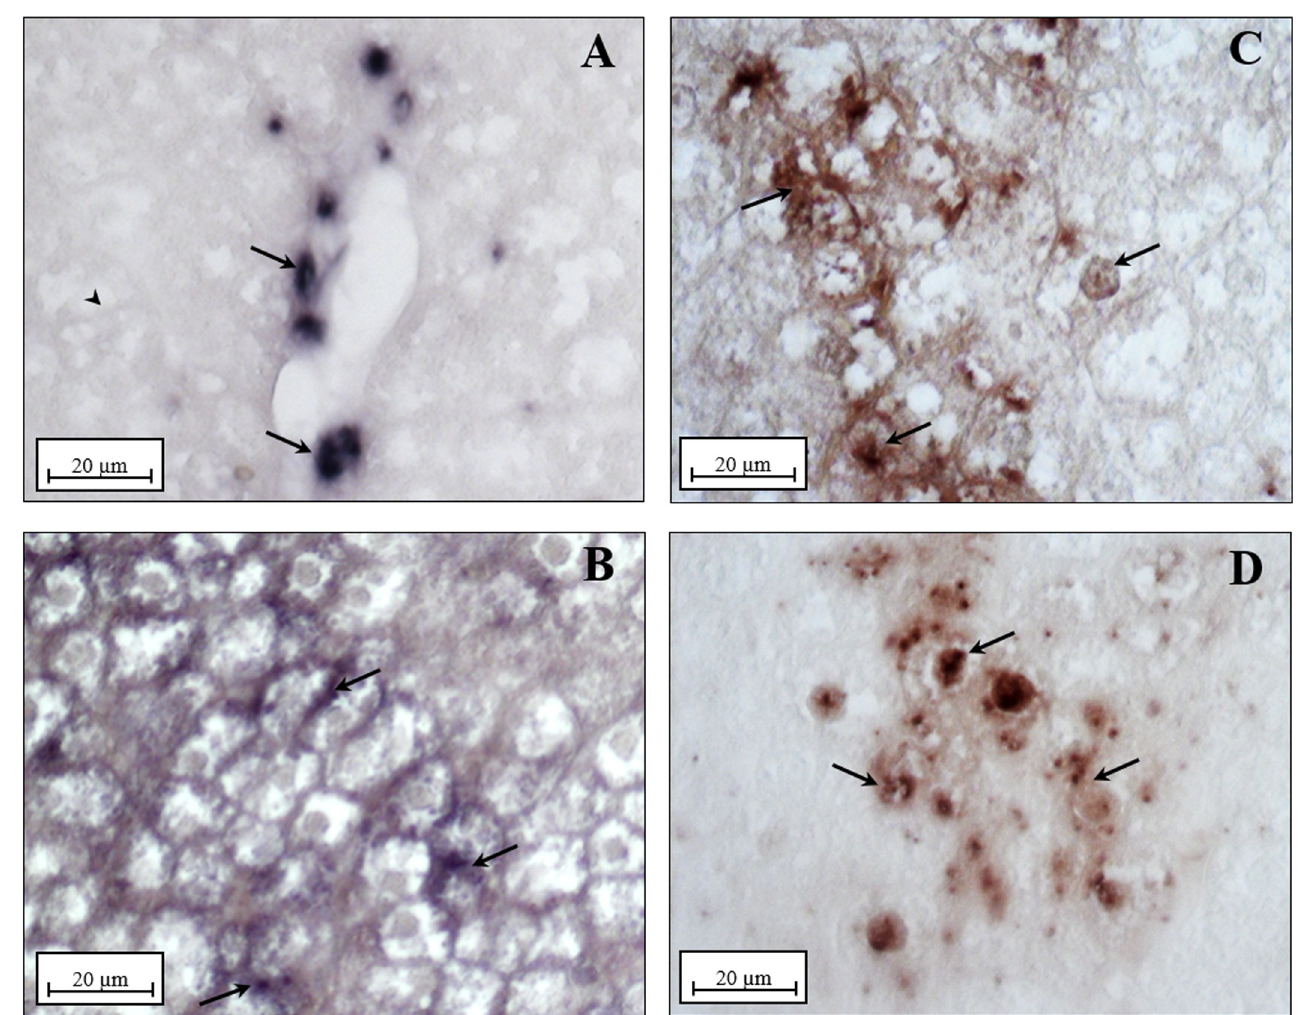
Fig 8. UCP2 mRNA localization in rat liver. Section of liver from rats fed with a standard diet (N, panel A): transcripts are localized only in Kupffer cells (black arrow), hepatocytes are unlabeled (arrowhead). In all the other groups (N+DDE, D, D+DDE, panels B, C and D respectively) transcripts are localized in both Kupffer cells and hepatocytes. Magnification used: 20X; Scale bar: 20 μ m.